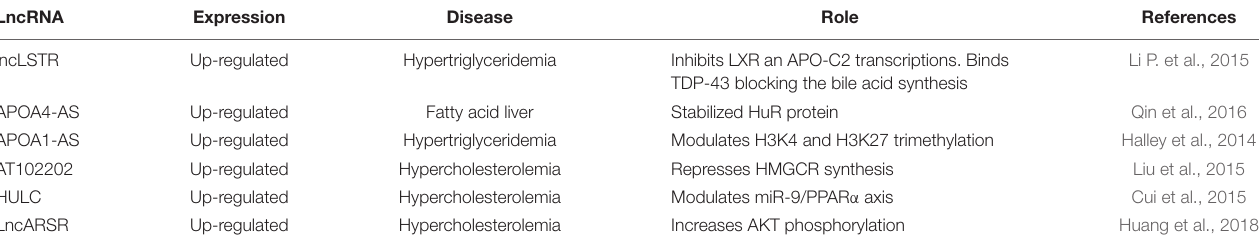
TABLE 5 | LncRNAs and lipids metabolism.